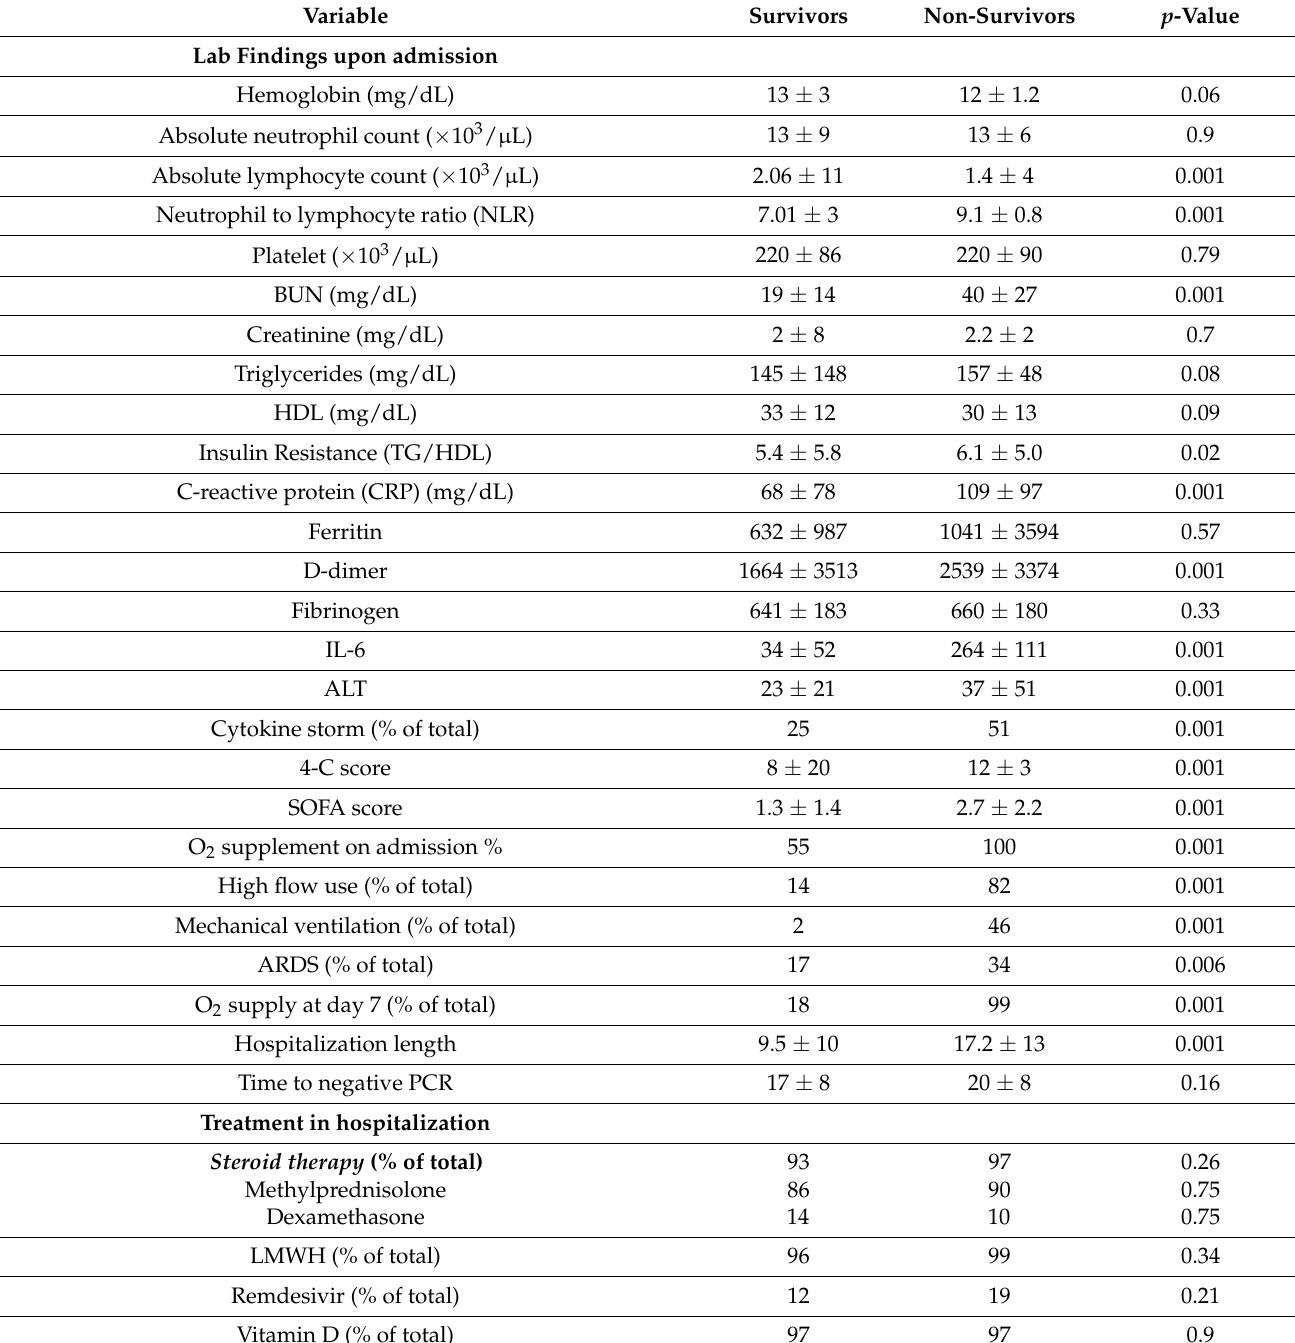
diabetes mellitus type 2, hypertension, lung disease, chronic kidney disease and